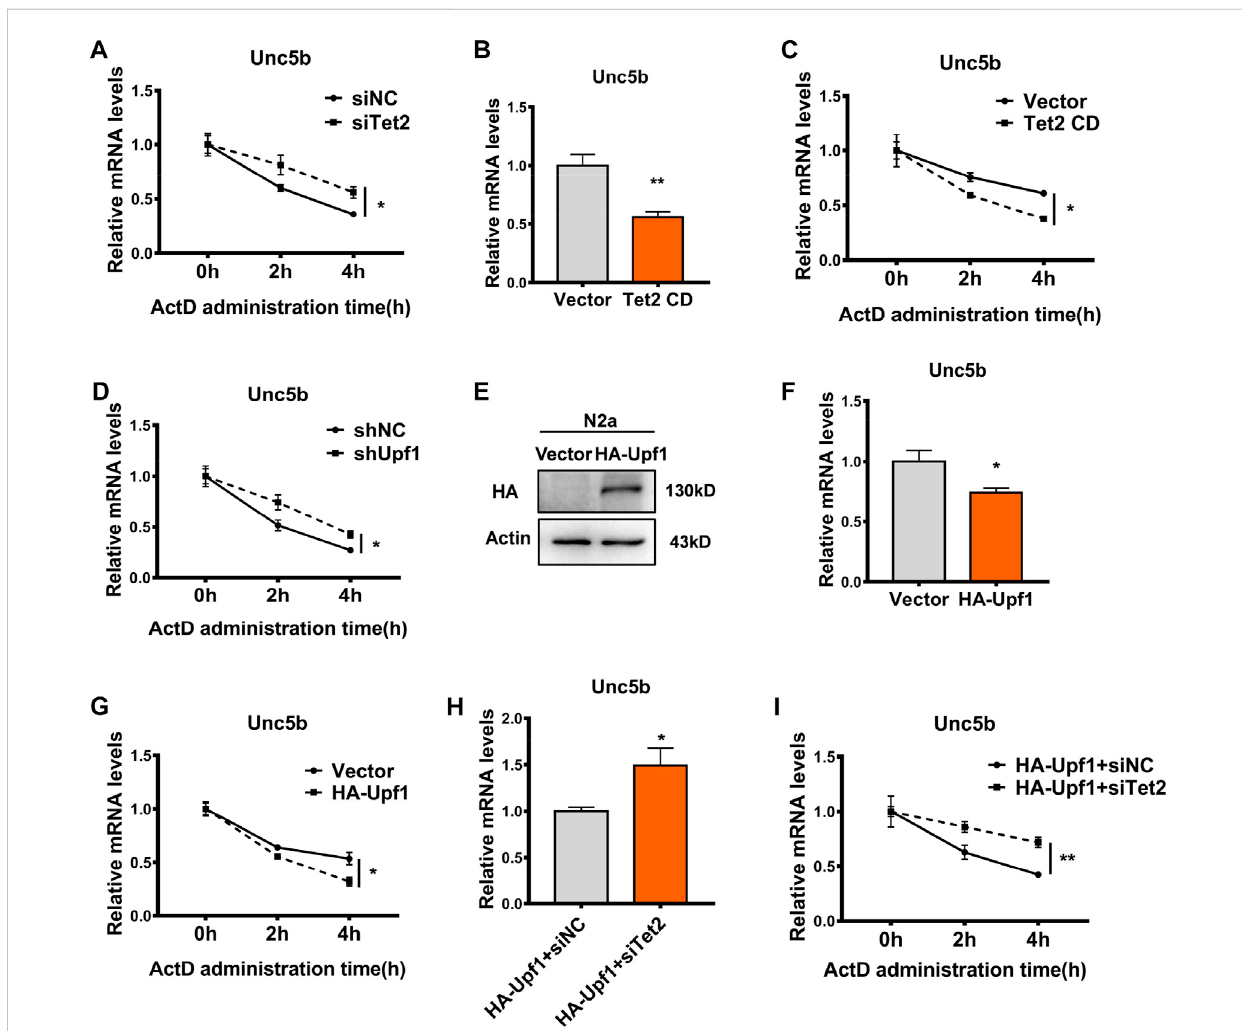
FIGURE 7 Tet2 – Upf1complexregulatedUnc5bmRNAstability. (A) StabilityofUnc5bmRNAbeforeandafterknockdownofTet2wasdetectedbyRT-PCR. n = 6, * p < 0.05. (B) mRNA levels of Unc5b before and after overexpression of Tet2 CD were detected by RT-PCR. n = 4, ** p < 0.01. (C) Stability of Unc5b mRNA before and after overexpression of Tet2 CD was detected by RT-PCR. n = 6, * p < 0.05. (D) RT-PCR to detect the stability of Unc5b mRNA before andafter knockdownofUpf1. n =3,* p < 0.05. (E) Westernblottodetectthetransfection ef fi ciencyofHA-Upf1inN2acells. (F) RT-PCRdetection of Unc5b mRNA levels before and after Upf1 overexpression. n = 4, * p < 0.05. (G) RT-PCR detection of Unc5b mRNA stability before and after Upf1overexpression. n =6,* p < 0.05. (H) Unc5bmRNAlevelsbeforeand afterTet2knockdownafter Upf1overexpression weredetected byRT-PCR. n = 4, * p < 0.05. (I) mRNA stability of Unc5b before and after Tet2 knockdown after Upf1 overexpression was detected by RT-PCR. n = 6, ** p < 0.01.3.2. Quanti fi ed data are normalized to thecontrol group, whose value is equal to 1. All data are presented as themean ± S.E.M. Unpaired two-tailed Student ’ s t-test was